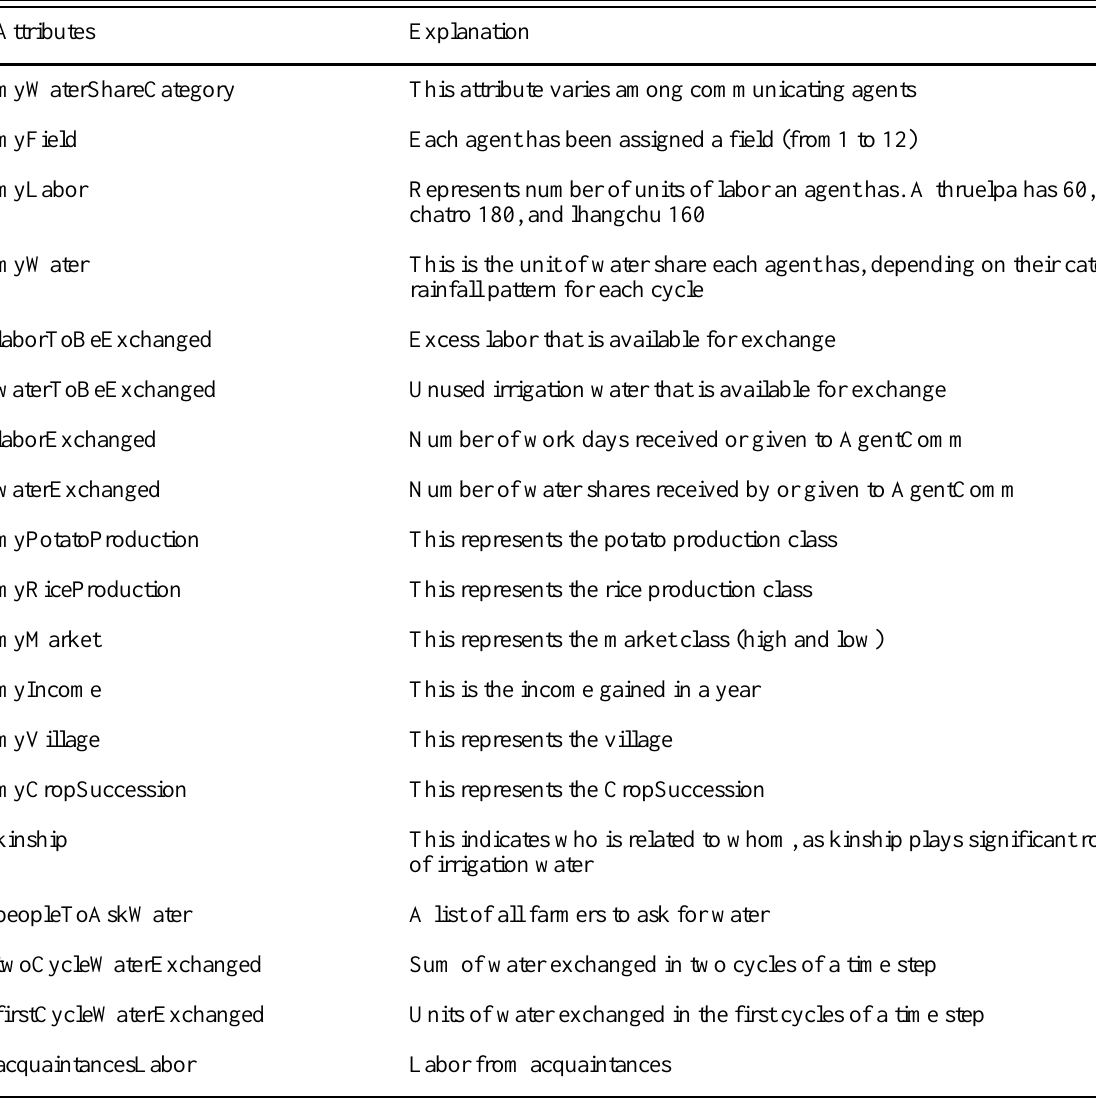
Table A2.1. Attributes of a social agent (Farmer) in the Limbukha model